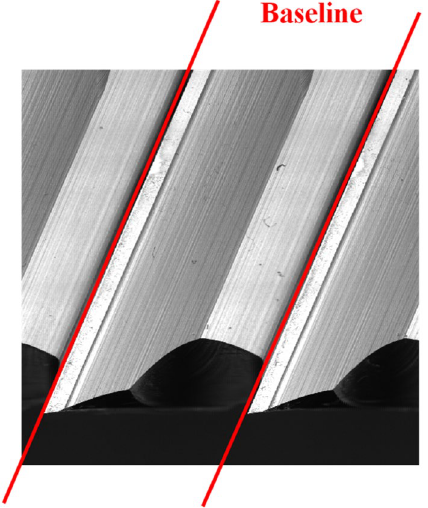
Figure 8. The expanded panorama image of spiral cutting